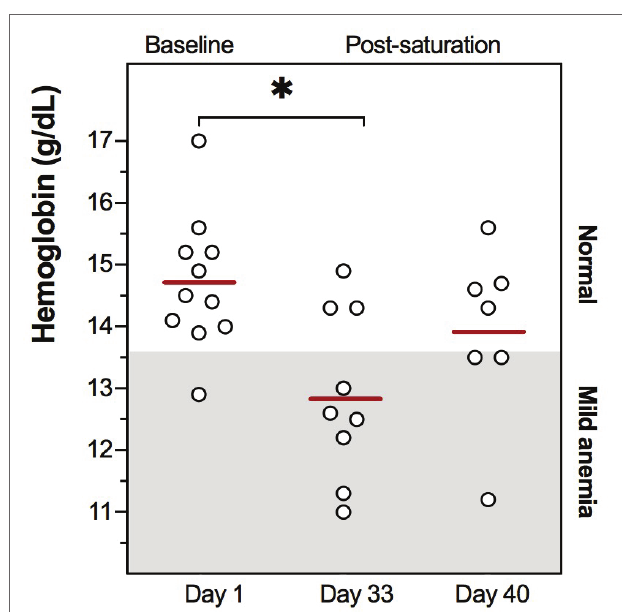
FIGURE 3 | Individual Hb values at pre-dive baseline (Day 1), 5 days post- saturation (Day 33), and 12 days post-saturation (Day 40). Means are shown as red lines. The range for mild anemia (Hb ≤ 13.6 g/dl) is indicated in gray. * p = 0.028.